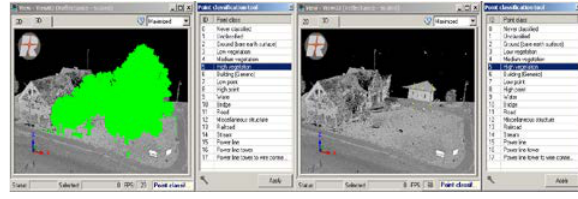
Figure 17: Point cloud after the high vegetation point classification